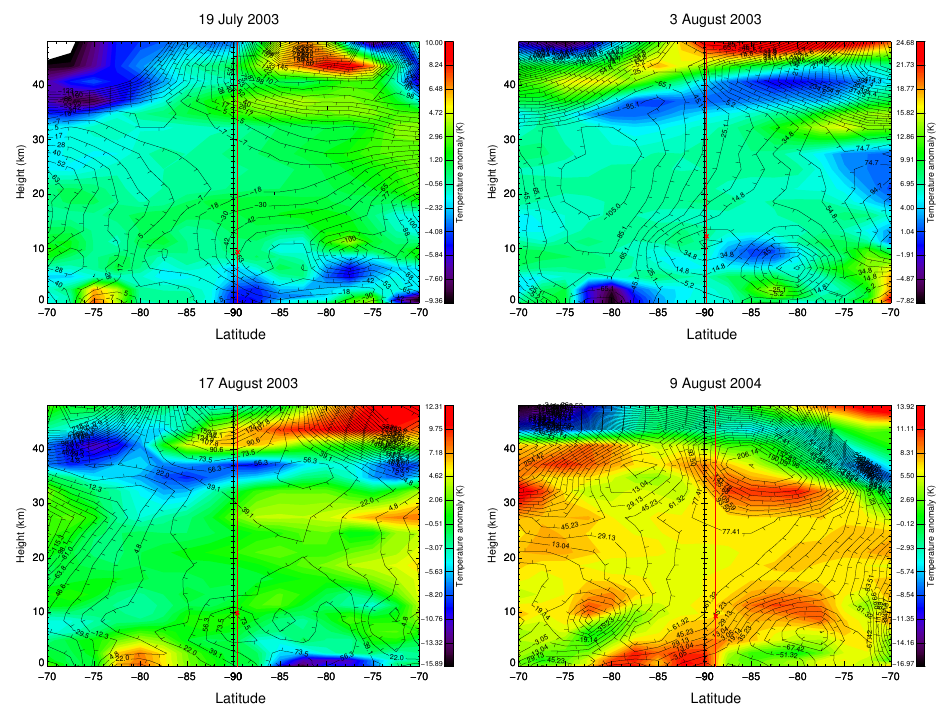
Figure 8. The 24h time differenced contour plots of geopotential height (black contours) and temperatures obtained from ECMWF Re- analysis from 0 to 50km along the direction of the ray path for waves observed on 19 July 2003 (top left), 3 August 2003 (top right), 17 August 2003 (bottom left), and 9 August 2004 (bottom right), as determined by our GROGRAT model runs. Ticks on contour lines point to lower geopotential height. The vertical red line marks the latitude at which the ray terminates, and the corresponding red “X” denotes the location of the wave source.